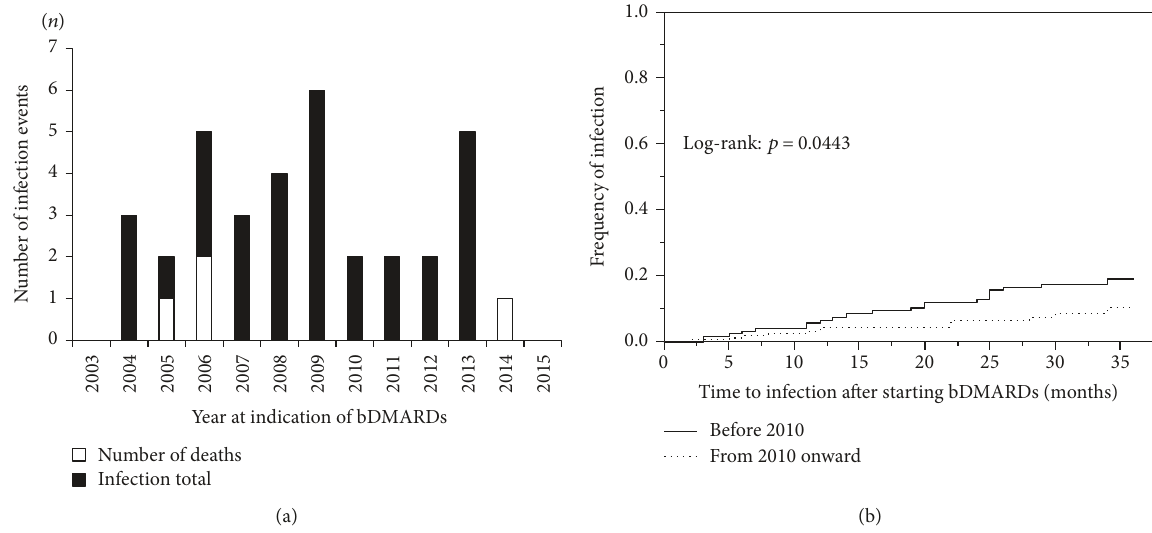
Figure 3: (a) Number of infections in the patients for whom a biological disease-modifying antirheumatic drug (bDMARD) was initiated each year. Open bars: the number of deaths in each year due to infections. Closed bars: the total number of infections for each year. (b) Cumulative incidence of hospitalized infections during the 3-year follow up, according to